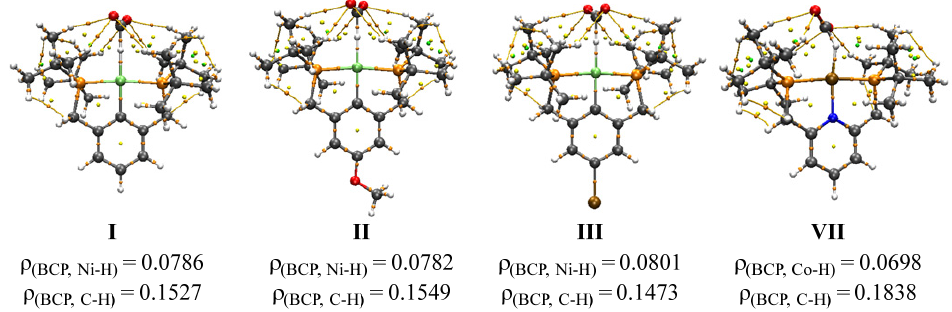
Figure 4. The critical points from atoms-in-molecules (AIMs) analysis of TM-(H)-formate complexes I , II , III, and VII . The orange balls represent the BCP (bond critical point), the yellow balls represent the ring critical point (RCP), and the bond paths for hydrogen bonds are shown in orange.